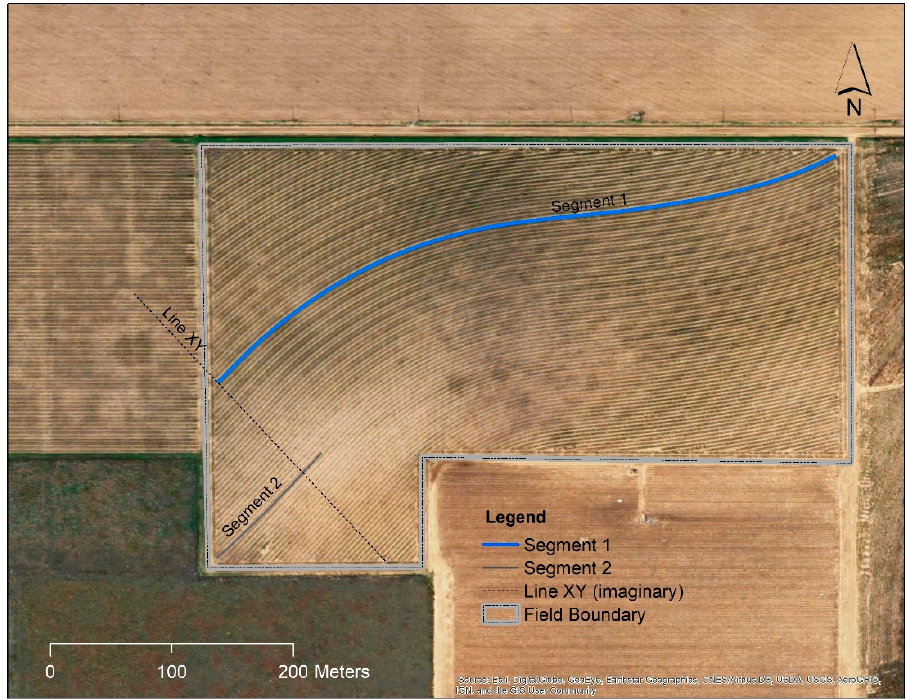
Figure 4. Challenge of multiple AB lines for one guidance pattern in a field with relatively simple slope conditions.